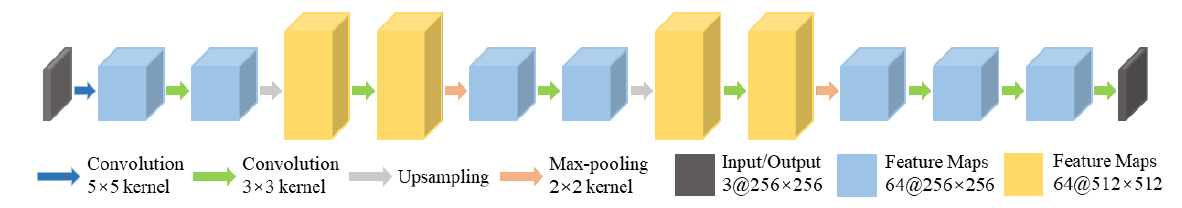
Figure 1. The framework of the RSCNN.